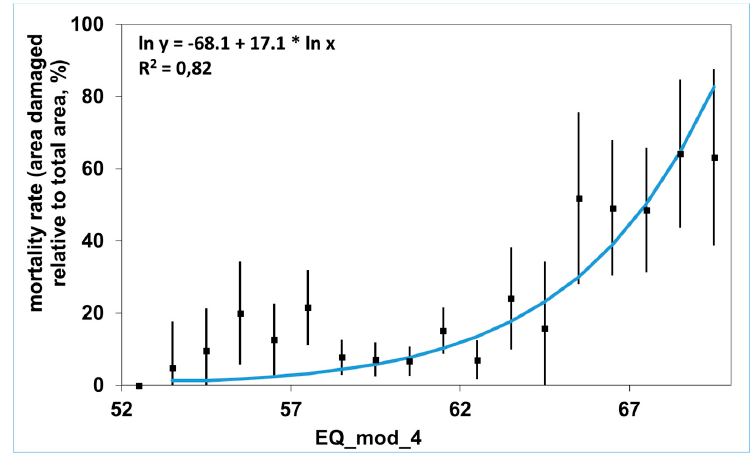
Figure A2. Relationship between drought (as measured by EQ_mod_4) and mortality by